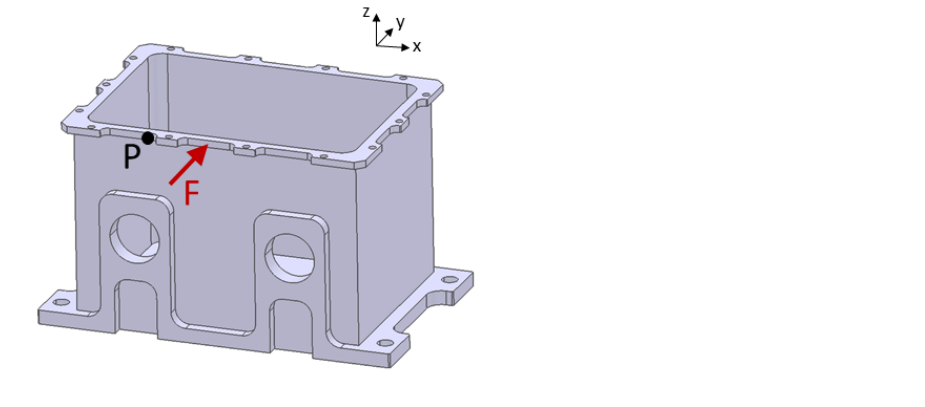
Figure 11. Excitation point of force F and measurement point P of displacement in frequency–domain